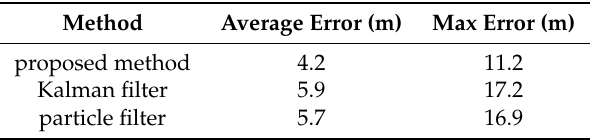
Table 5. The average and maximum positioning error comparisons if 10% of outliers in PDR positioning are